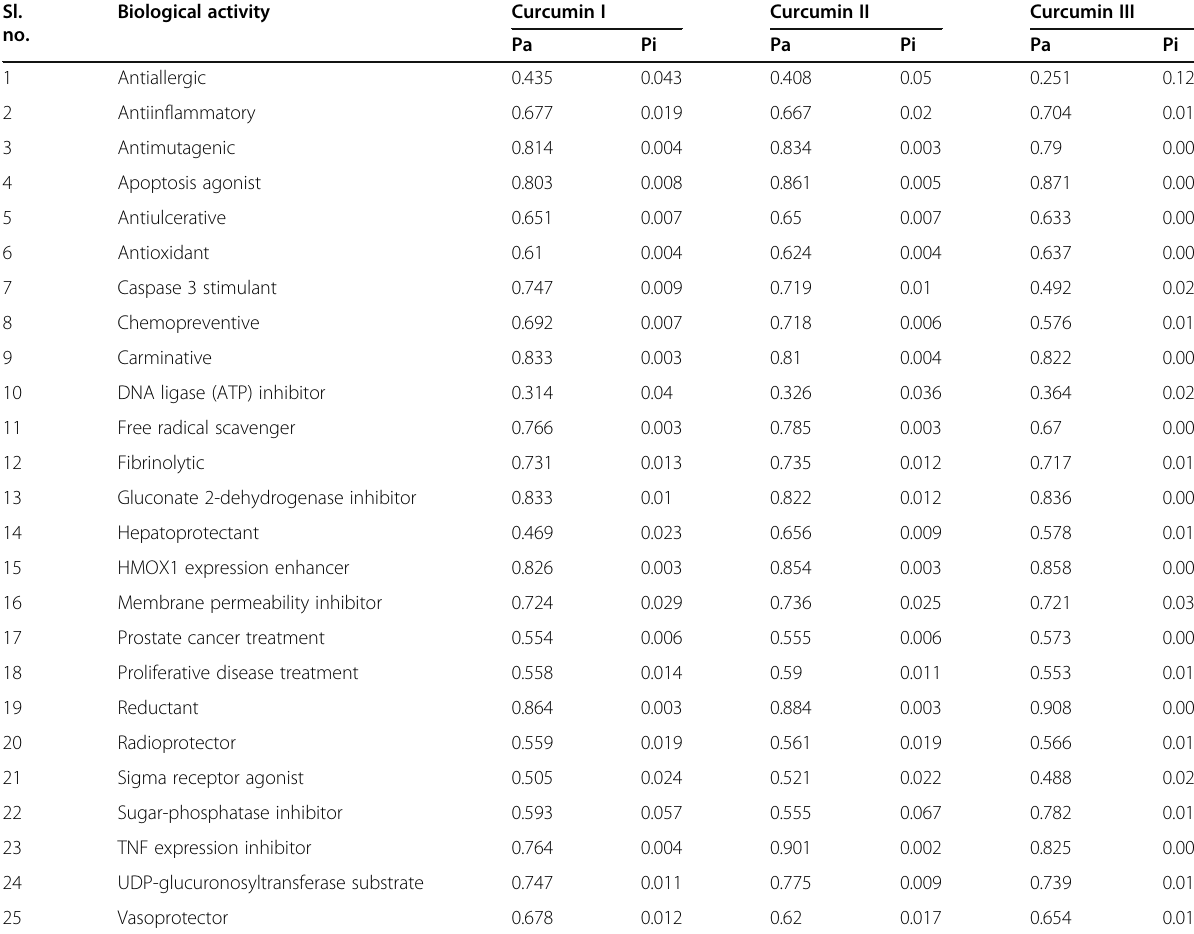
Table 4 Pharmacological activities of curcumin I (PubChem CID: 969516), curcumin II (PubChem CID: 5469424), and curcumin III (PubChem CID: 5315472). When Pa > 0.7: compound is very likely to exhibit the activity; when 0.7 > Pa > 0.5: compound is likely to exhibit the activity; when Pa < 0.5: compound is less likely to exhibit the activity Sl.